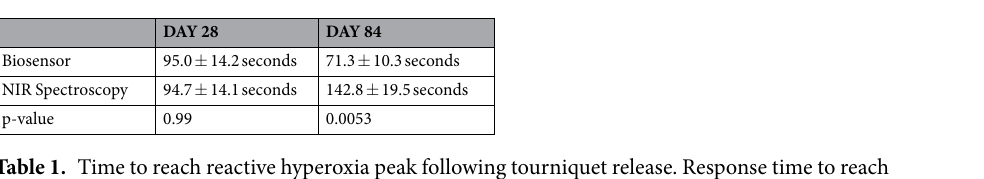
Table 1. Time to reach reactive hyperoxia peak following tourniquet release. Response time to reach reactive hyperoxia peak after tourniquet release. Day 28 shows no difference in response time between the two techniques. However, by Day 84, biosensor shows a significantly faster response than NIR spectroscopy. (n =